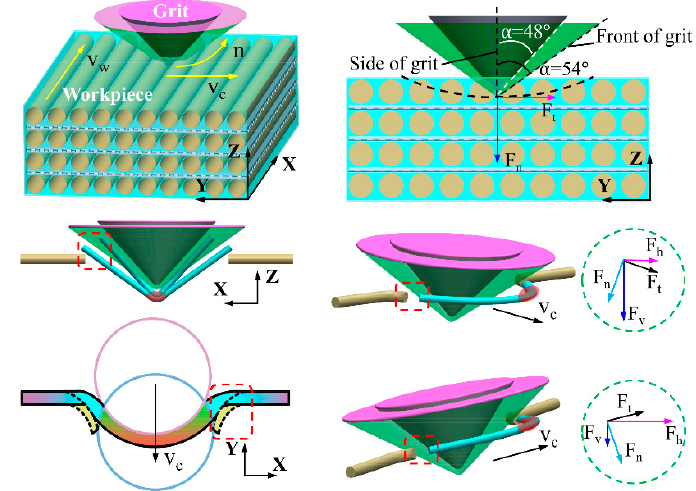
Figure 10. Schematic diagram showing the cutting mechanism for spherical cone tools when λ = 90 ° .